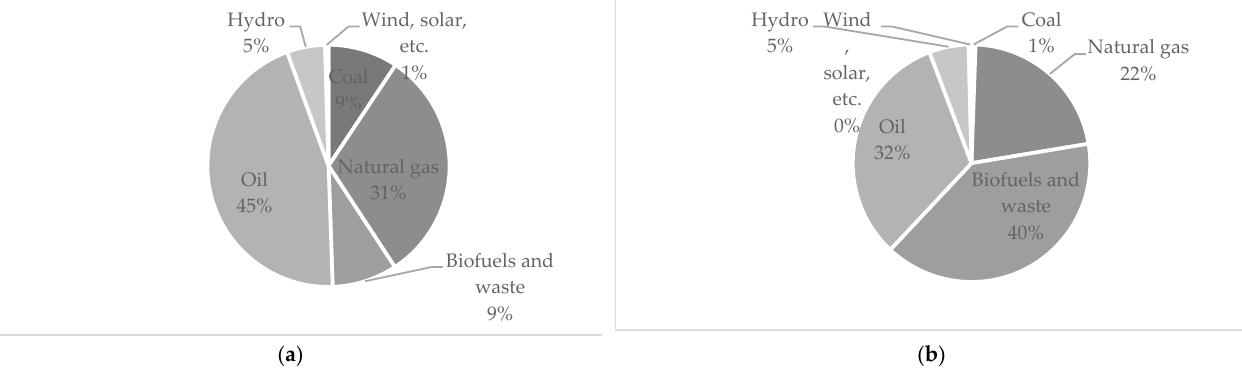
Figure 8. Structure of energy supply in Latvia: ( a ) 1990; ( b ) 2020. Source: authors’ compilations based on database of the International Energy Agency.